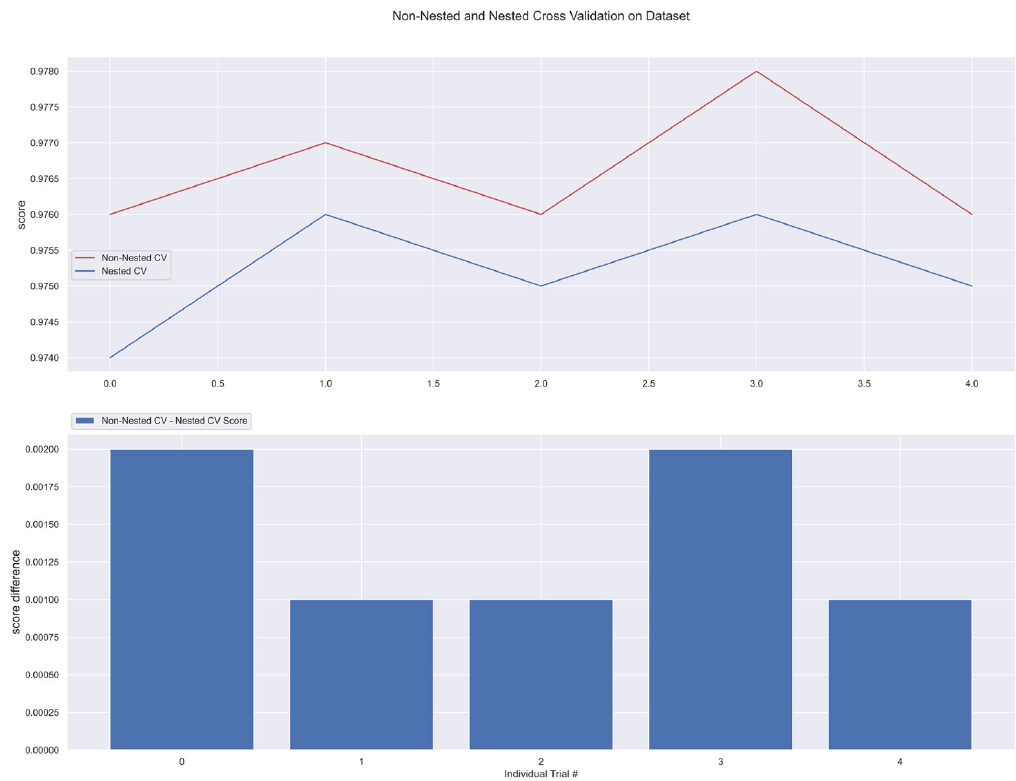
Figure 17. Non-Nested and Nested cross-validation on LR algorithm.